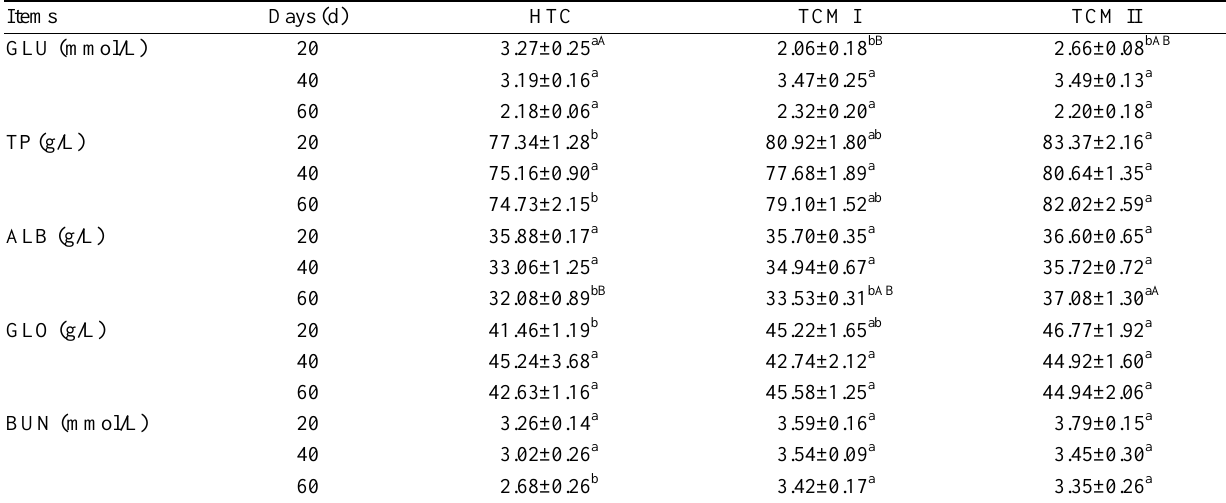
Table 5. Effects of two TCM treatments on blood biochemical parameters of heat stressed beef cattle Items